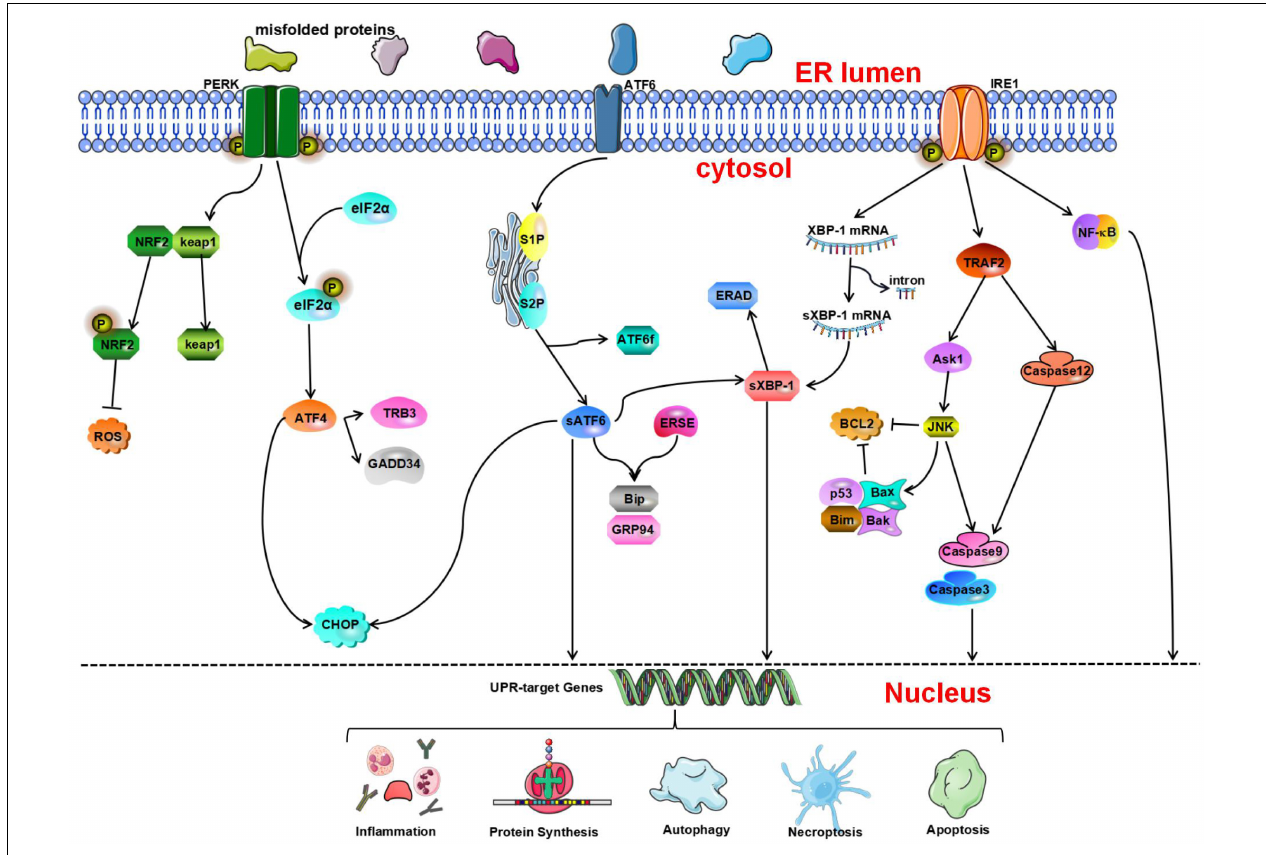
FIGURE 1 | The unfolded protein response (UPR) determines cell fate through the protein kinase R-like endoplasmic reticulum kinase (PERK), inositol-requiring enzyme 1 (IRE1), and activating transcription factor 6 (ATF 6) pathways. Nuclear factor erythroid 2-related factor 2 (NRF2) is phosphorylated by PERK and dissociates from Kelch-like ECH-associated protein 1 (Keap1) under oxidative stress conditions and then activates the expression of NRF2-dependent antioxidant genes. p-eIF2a can inhibit protein synthesis. Activated ATF4 induces the expression of growth arrest and DNA damage-inducible gene 34 (GADD34) and tribbles-related protein 3 (TRB3). ATF6 is cleaved by serene protease site 1 protease and site 2 protease (S1P and S2P, respectively) to generate ATF6f and activated sATF6. Then, it combines with endoplasmic reticulum stress response elements (ERSEs) to regulate and activate the expression of BiP and glucose regulating protein 94 (GRP94). In addition, IRE1 contributes to ERS-mediated apoptosis through the tumor necrosis factor receptor-associated factor 2- activate apoptosis signal-regulating kinase-1-c-Jun N-terminal kinase (TRAF2-ASK1-JNK) and caspase-12 pathways. In addition, inositol-requiring enzyme 1 α (IRE1 α ) can activate the nuclear factor κ B (NF- κ B) signaling pathway to initiate inflammatory